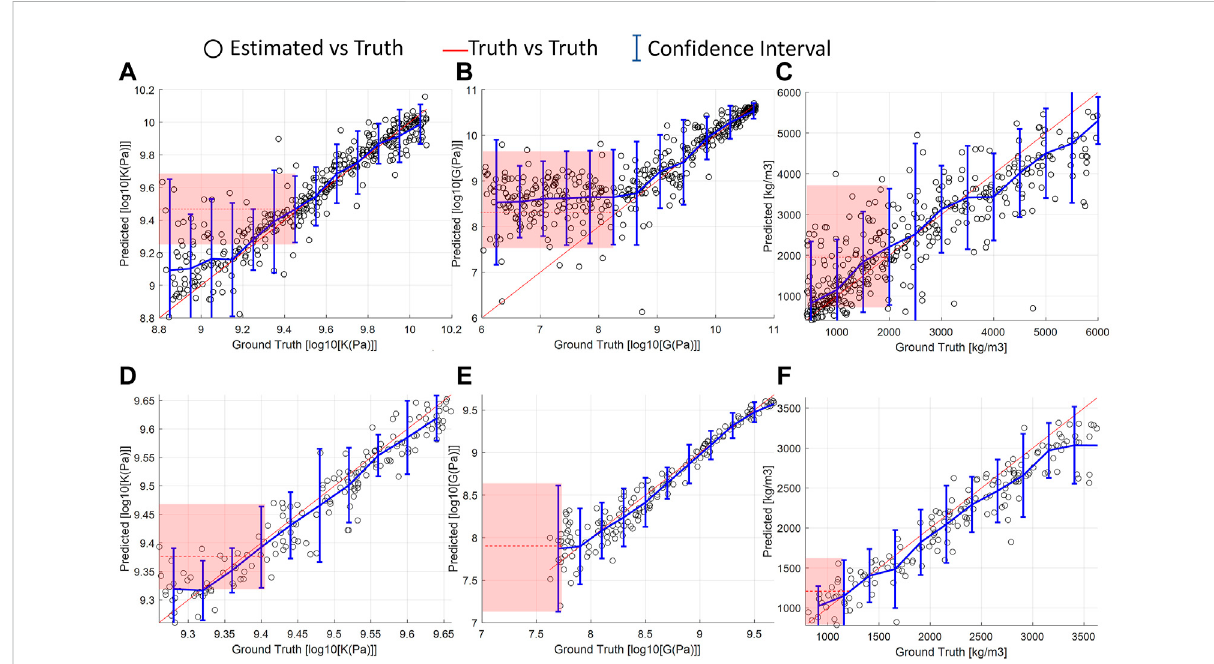
FIGURE 3 Test set estimation of bulk modulus (A,D) , shear modulus (B,E) , and mass density (C,F) . Bulk and shear moduli are plotted on log scales. Dotted arrows indicate predicted values using the measured echo from the metamaterial sample, and the highlighted regions illustrate the con fi dence intervalsforthosepredictions.The fi rstrowshowsestimatedvaluesinthelarge M spaceandthesecondrowshowsthosefromthereducedmaterial space M ′ . The con fi dence intervals (error bars) are signi fi cantly smaller for the lower row. The estimated values from the metamaterial sample bounded by the con fi dence interval highlighted in (D – F) show excellent agreement with the reported values published in